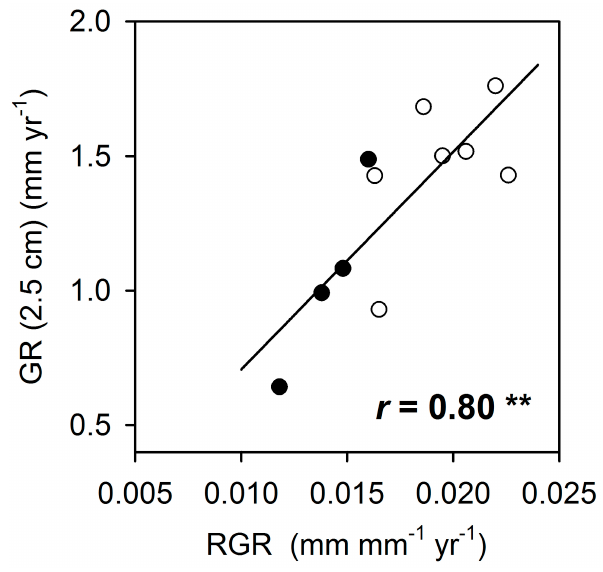
Figure 1. Relationship between the estimated growth rate (GR) standardized to 2.5 cm diameter and the average relative growth rate (RGR) values observed for seven deciduous (open circle) and four evergreen (filled circle) liana species. Note: ** p < 0.01.